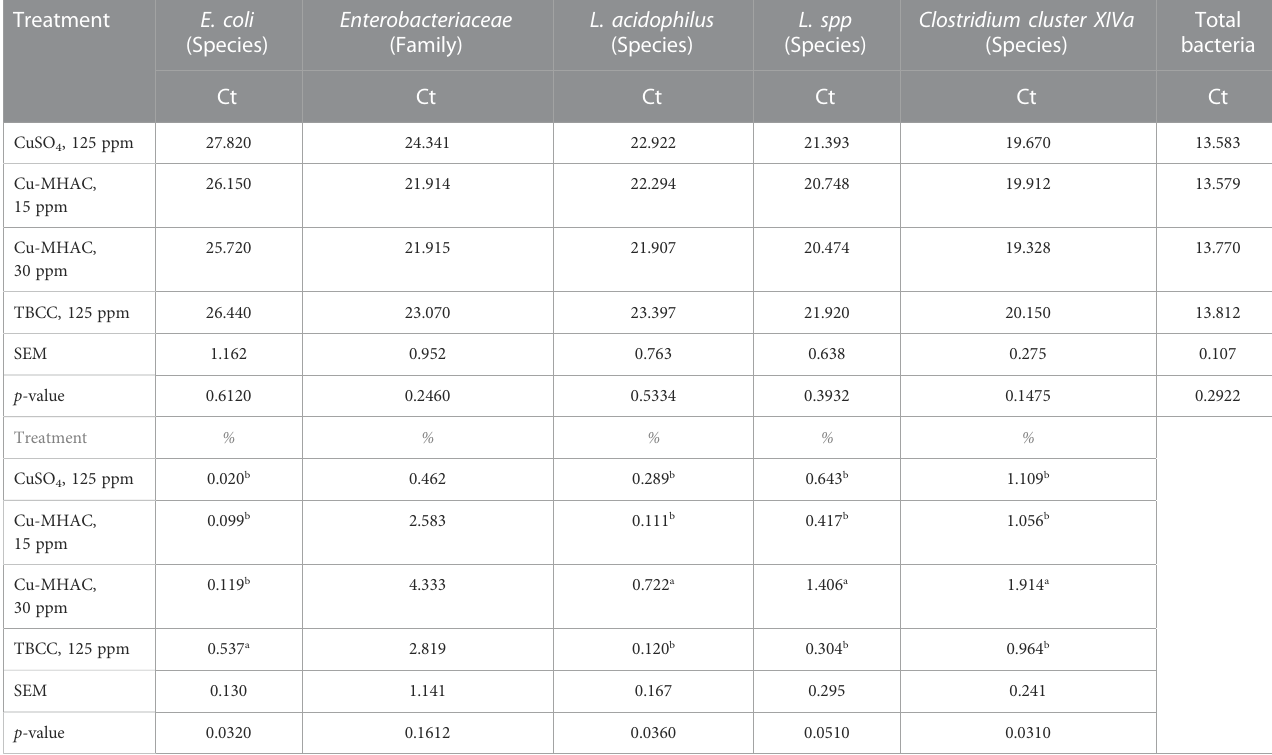
TABLE 13 The Ct of E. coli , Lactobacillus acidophilus , Lactobacillus spp . and Clostridium cluster XIVa (% of total bacteria) per ng of cecal DNA and the relative population (%) of E. coli , Lactobacillus acidophilus , Lactobacillus spp . and Clostridium cluster XIVa (% of total bacteria) in the cecum of broilers at 29 days of age in experiment #3.